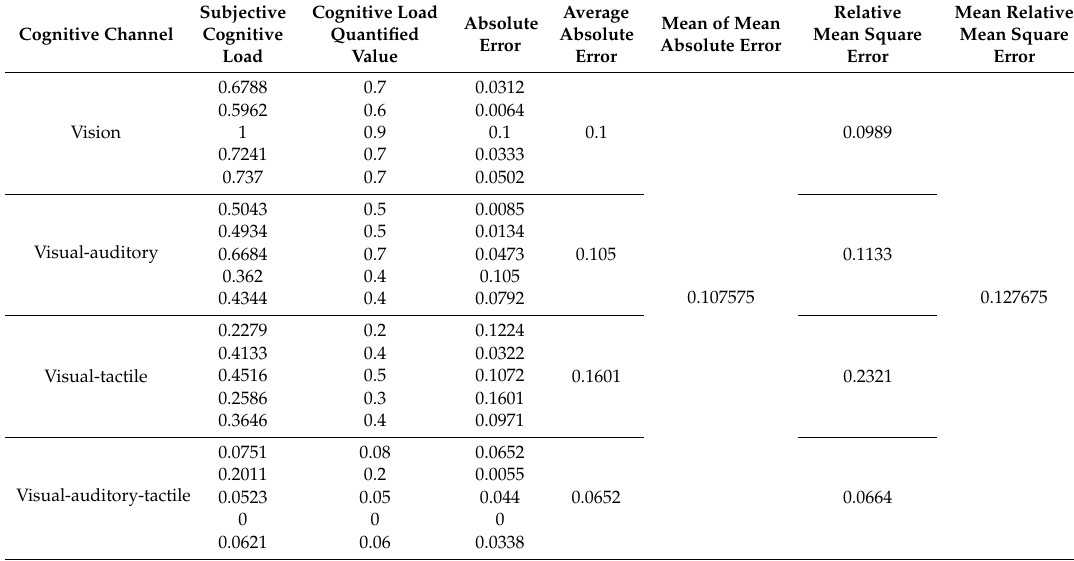
Table 9. Maximum absolute error and relative mean square error.